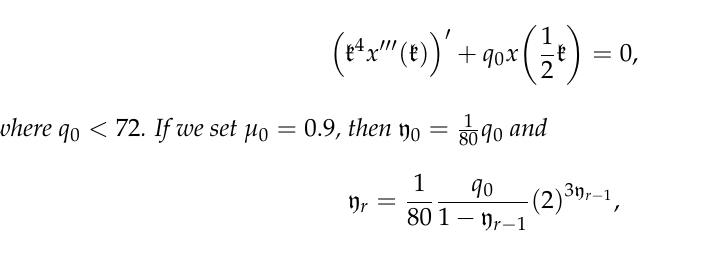
Figure 1. The iterations y r , for r = 0,1, . . . ,6 in the special case 1. Special case 2: Consider the delay equation